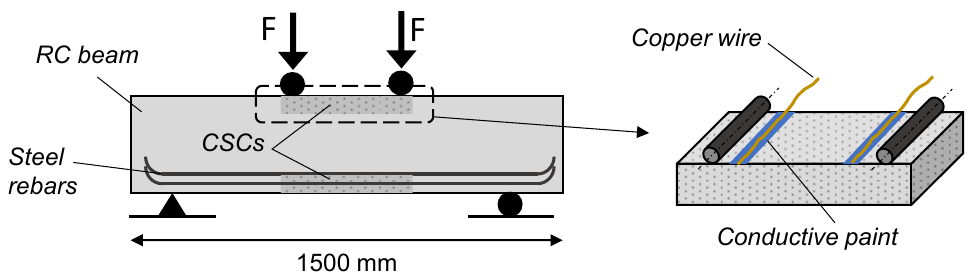
Figure 7. Cast-in-situ CSC sensors installed at top and bottom surfaces of the midspan section of a RC beam (adapted from [79]).